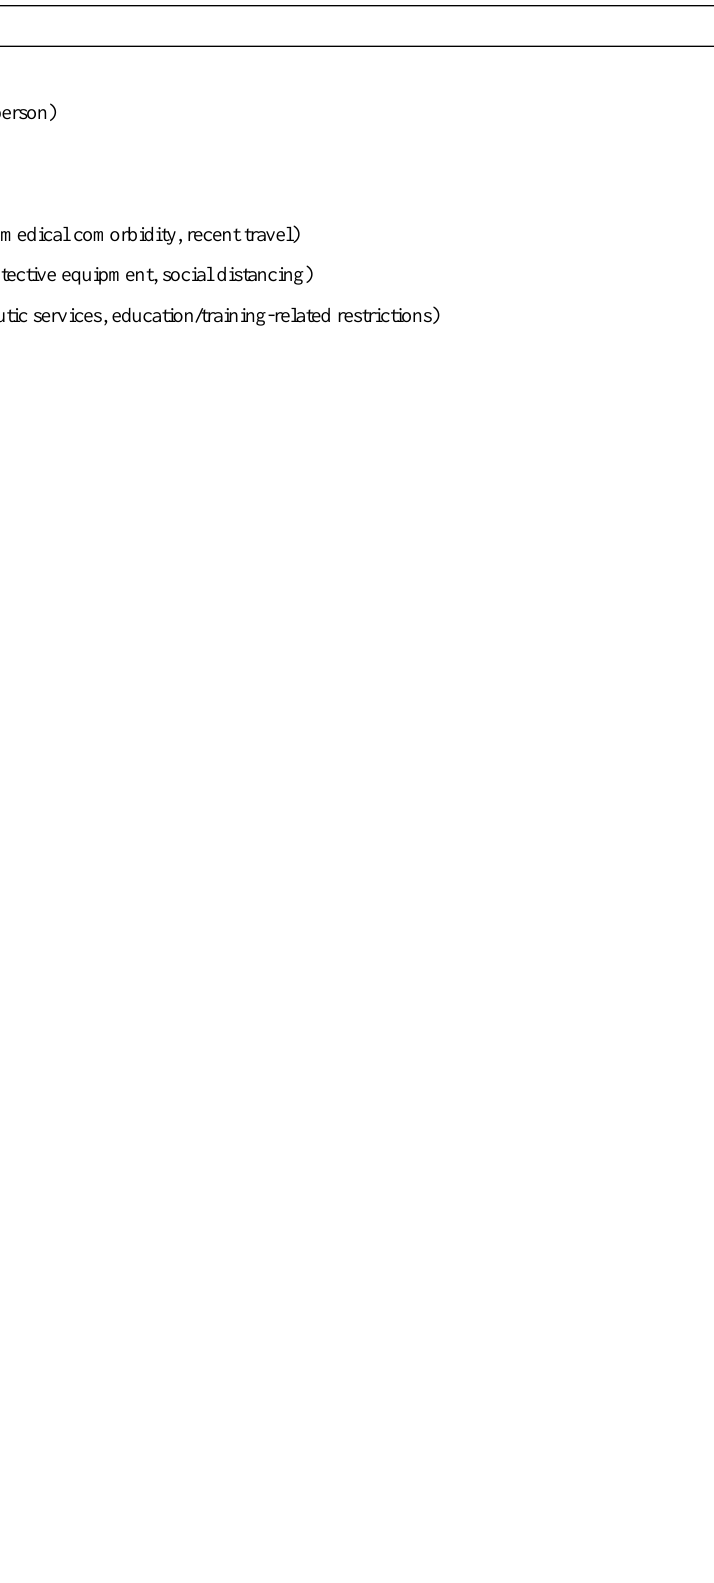
Table 3. Descriptive statistics of practice adjustments, patients seen, and tele–mental health factors during COVID-19 for the full sample